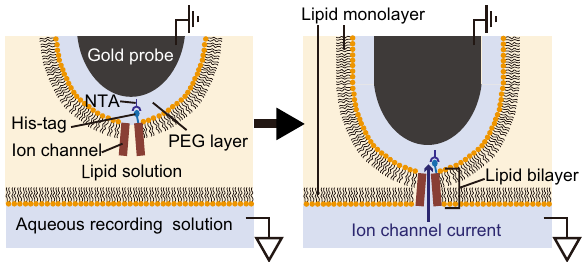
Figure 1. Schematic illustration of an artificial lipid bilayer single-channel recording using a gold probe. The ion channels immobilized on the surface of the probe are incorporated into a lipid bilayer membrane at the same time as the membrane is formed at the interface between the aqueous recording and lipid solution by making the probe move through a lipid solution toward an aqueous one.